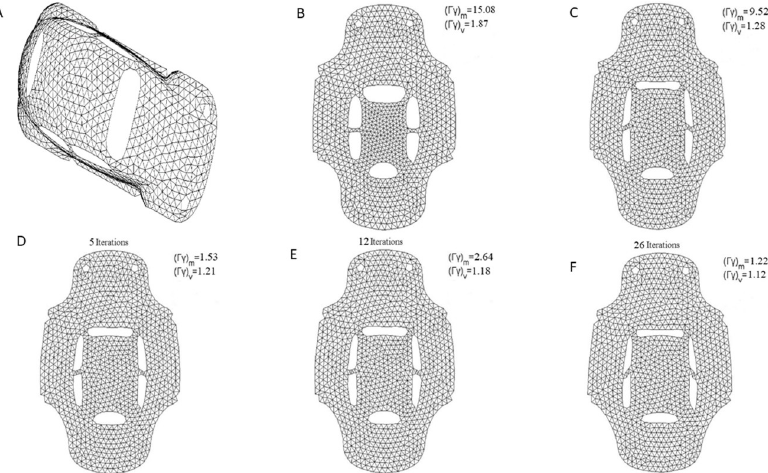
Fig 13. Parameterization experiments on beetle model. (A) original mesh model,(B) result by LABF, (C) result by LQHP,(D) result by IQCP, (E) result by QCTM, (f) result by our method.